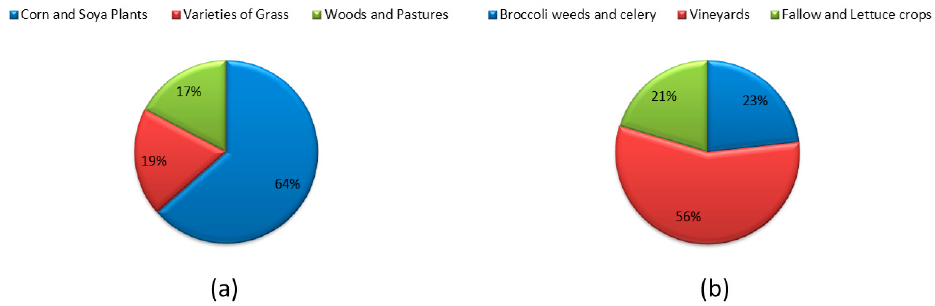
Figure 5. Different class regions ( a ) Indian Pines ( b ) Salinas.